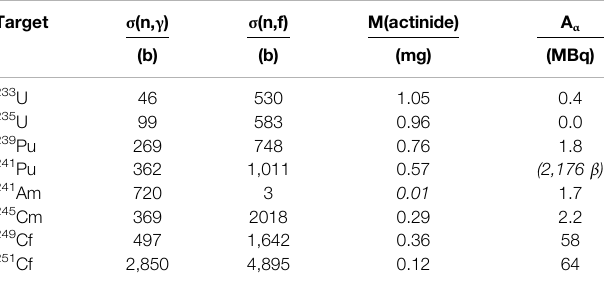
FIGURE 15 | Detection ef fi ciency for simultaneous detection of a pair of 84 Geand 150 NdFFemitted back-to-back,bothleaving 235 UO 0.2 – 2 mg/cm 2 thickness and both depositing energies above the given threshold in the respective detector.